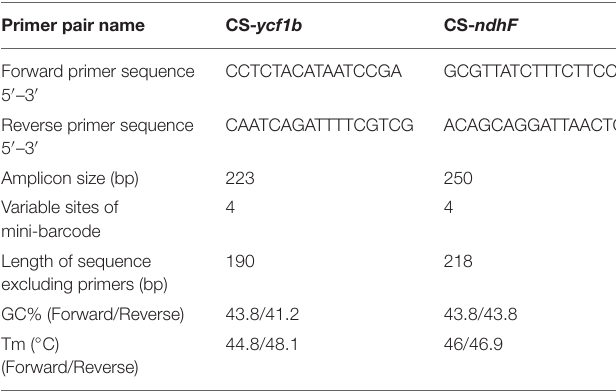
TABLE 4 | Primer information of two